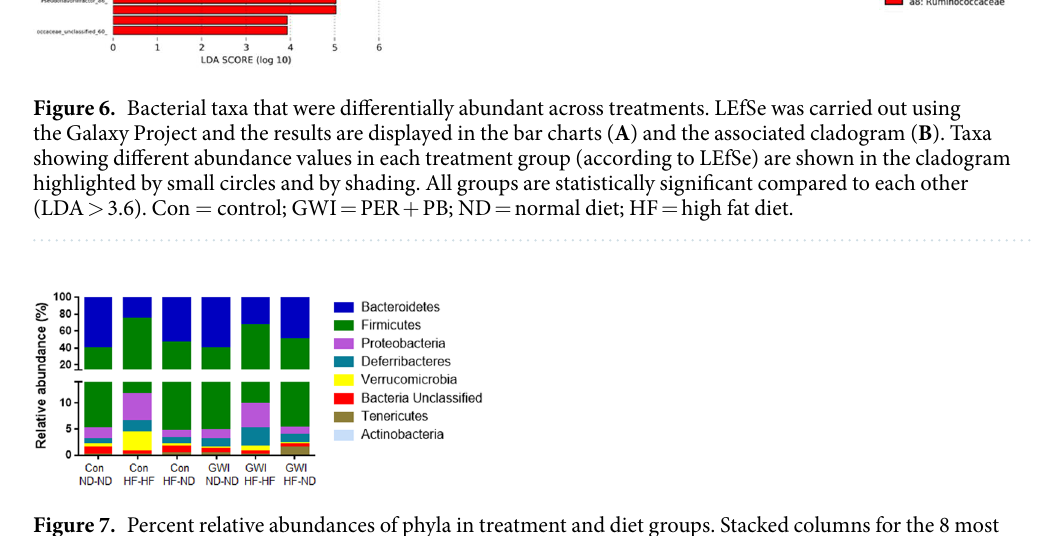
Figure 7. Percent relative abundances of phyla in treatment and diet groups. Stacked columns for the 8 most prominent phyla are included. Con = control; GWI = PER + PB; ND = normal diet; HF = high fat diet.